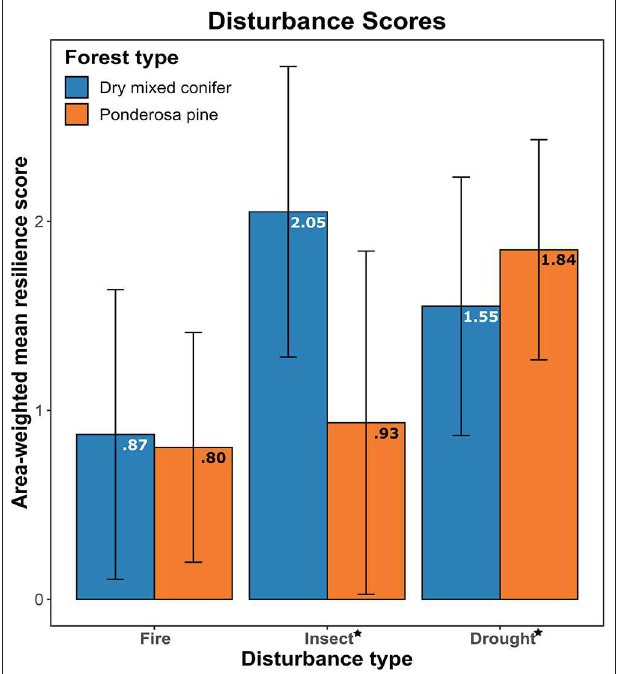
FIGURE 3 | Comparison of mean scores ± standard deviation in each disturbance category by forest type. The maximum possible score in each category is 3 points. Inset numbers give the actual value represented by each bar. The ⋆ on the x axis denotes a significant difference in the resilience scores between the forest types ( t -test, p < 0.05). The insect disturbance signifies western spruce budworm in the dry mixed conifer forest type and bark beetles in the ponderosa pine type.